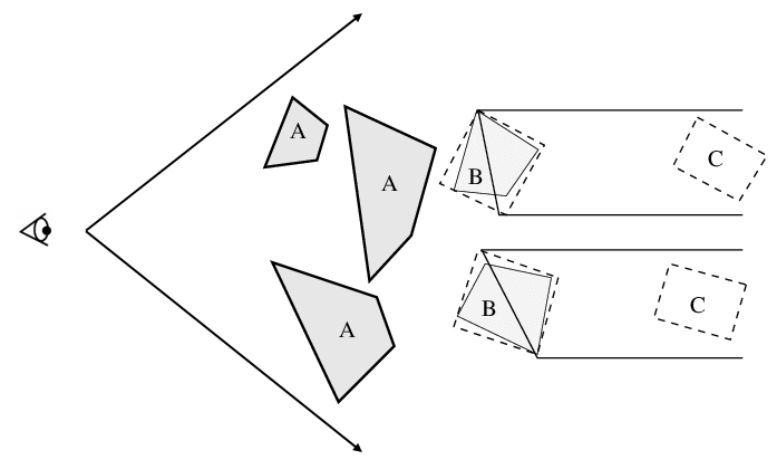
Figure 13. A mask test performed using an OpenGL depth buffer (A indicates visible geometry; B indicates testing with OpenGL; and C indicates testing with other software methods).